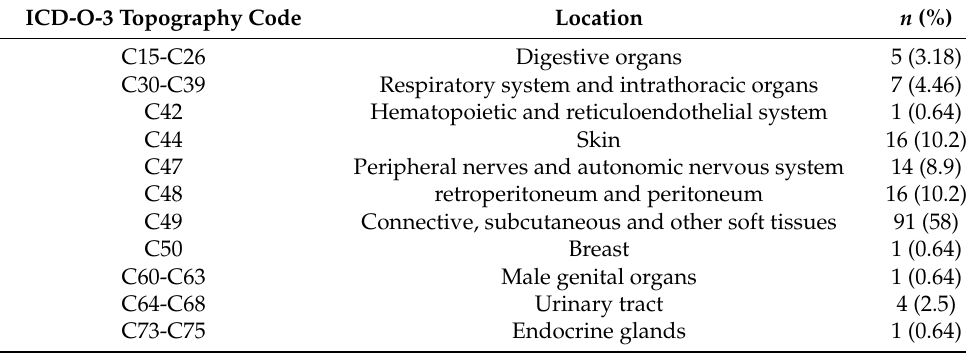
Table 3. Topography distribution of soft tissue